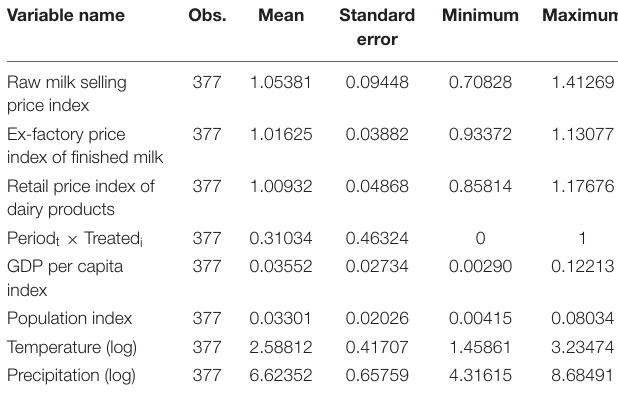
TABLE 2 | Variables for descriptive